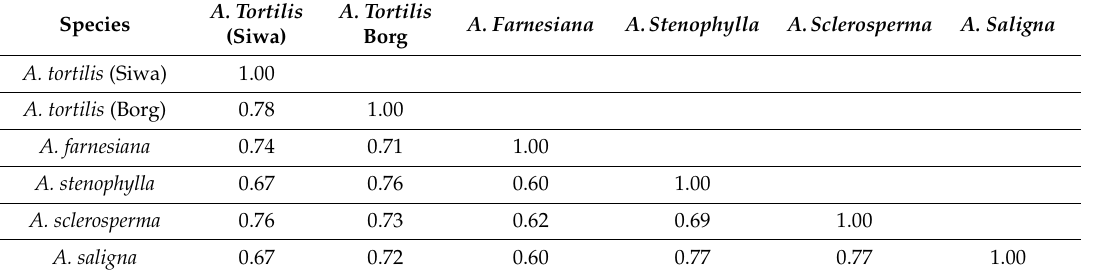
Table 5. Similarity indices (%) among Acacia species based on 43 random amplified polymorphic DNA (RAPD)